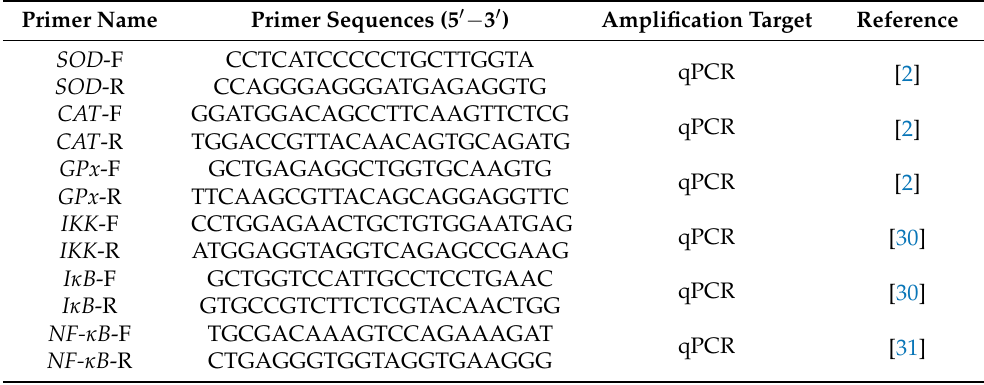
Table 1. Primers used for amplification and mRNA expression